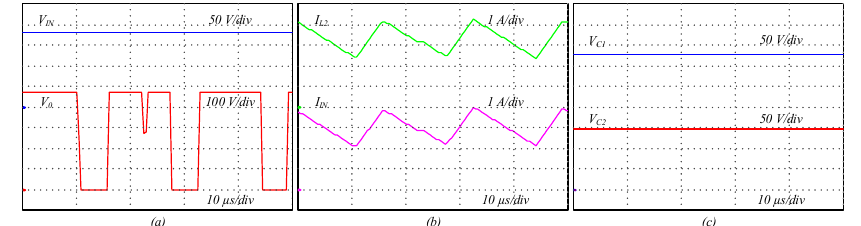
Figure 17. Simulation results of the qZS inverter: ( a ) Input voltage ( V in ) along with the dc-link voltage ( V o ), ( b ) input current ( I in ) along with the inductor current ( I L 2 ), and ( c ) voltage across capacitors V C 1 and V C 2 .